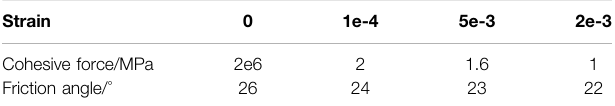
TABLE 4 | Coal strain-softening